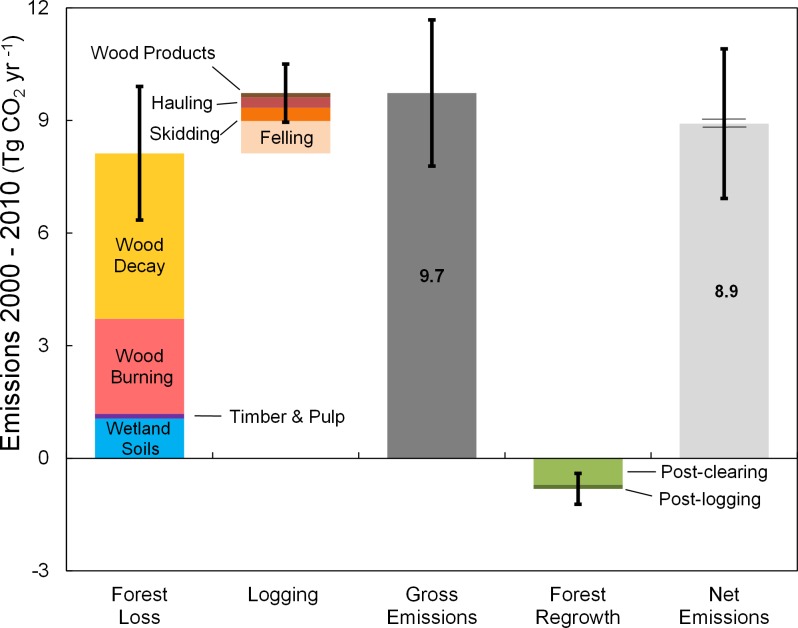
Gross and net emissions, in millions of tonnes (Tg) of CO2, are represented according to forest loss, logging, and sequestration components.Values represent annual means during the 2000–2010 period acrossBerau. The wider bars just above and below the top of the net emissions column represent the width of error bars (±1%) if we had only accounted for uncertainty in our activity dataset and map-based uncertainty in our biomass dataset.